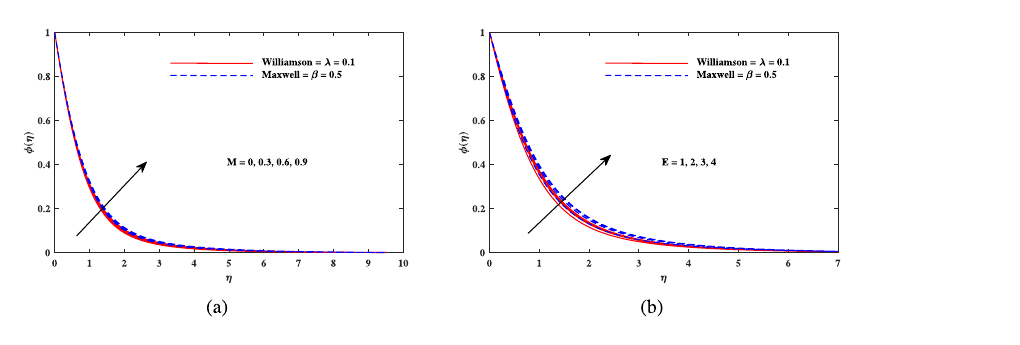
Figure 6. Concentration φ(η) fluctuation with ( a ) M and ( b ) E